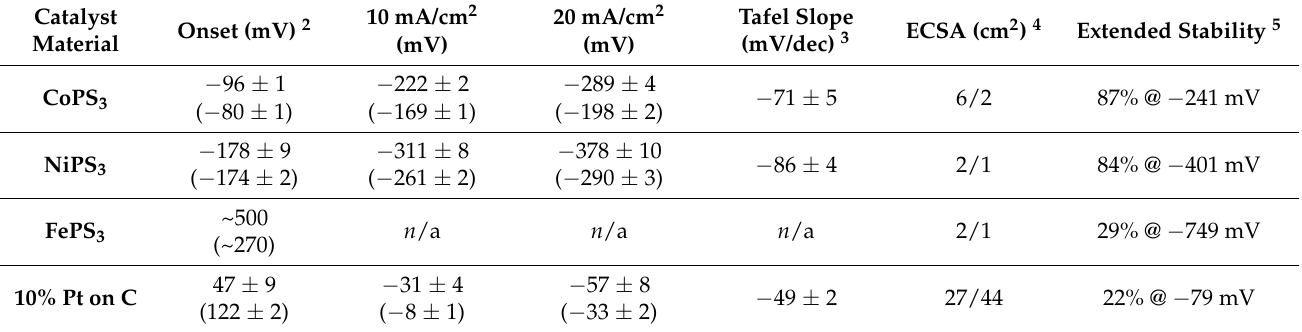
Table 3. Summary of key electrochemical and electrocatalytic HER results for MPS 3 materials 1